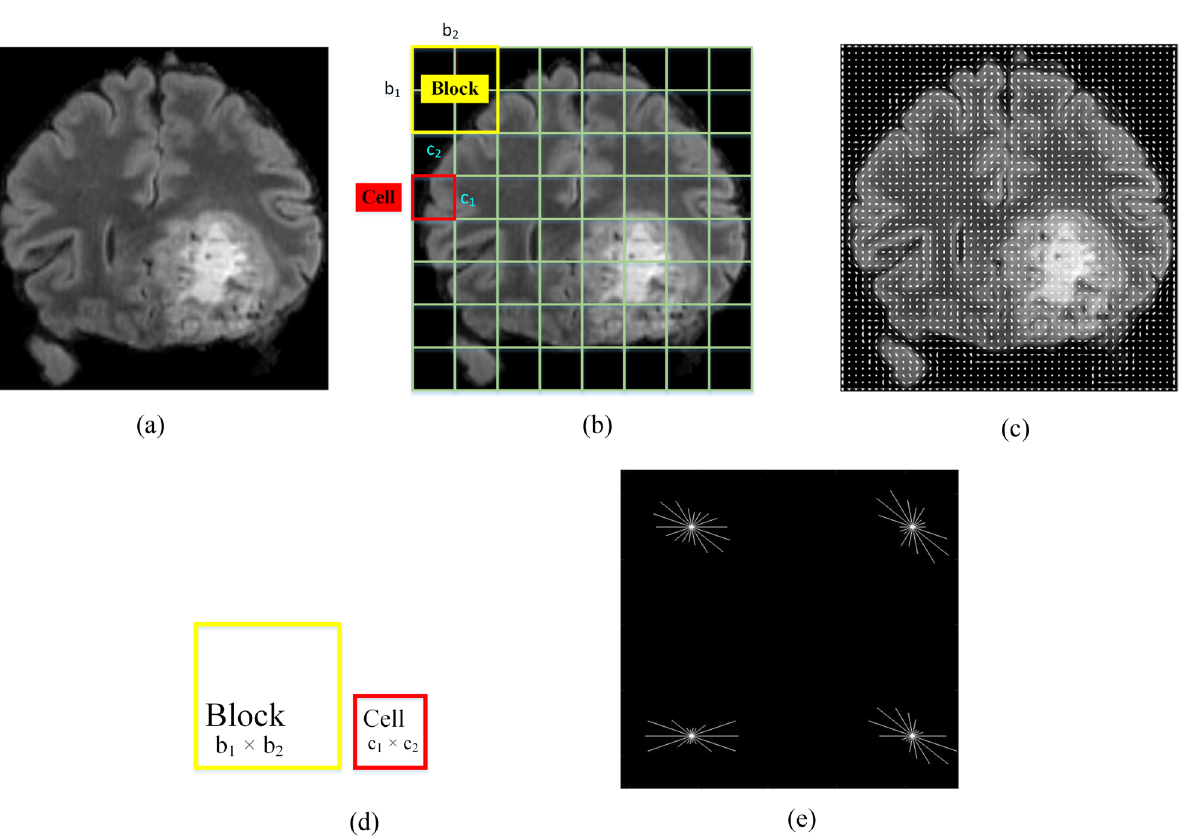
Figure 7. Schematic diagram of FEM for HOG features; ( a ) a rescaled mpMRI scan for radiogenomic dataset, ( b ) schematic HOG cells and blocks superimposed on ( a ), ( c ) HOG descriptors, ( d ) cell and block representation, and ( e ) the magnified view of a single